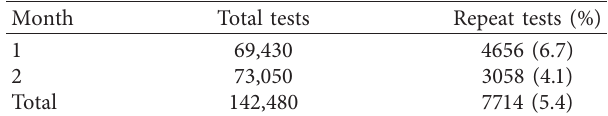
Table 3: Total tests and repeat tests over two consecutive